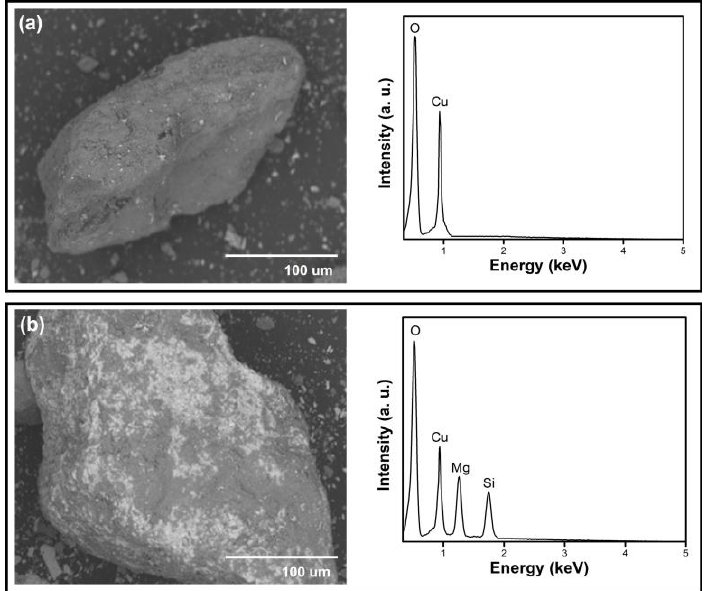
Figure 4. FE-SEM images and EDS analysis results of the malachite surface ( a ) and the TN-deposited malachite surface ( b ), respectively. The deposition tests were performed using 1500 g/ton TN-2 concentration at pH 6.